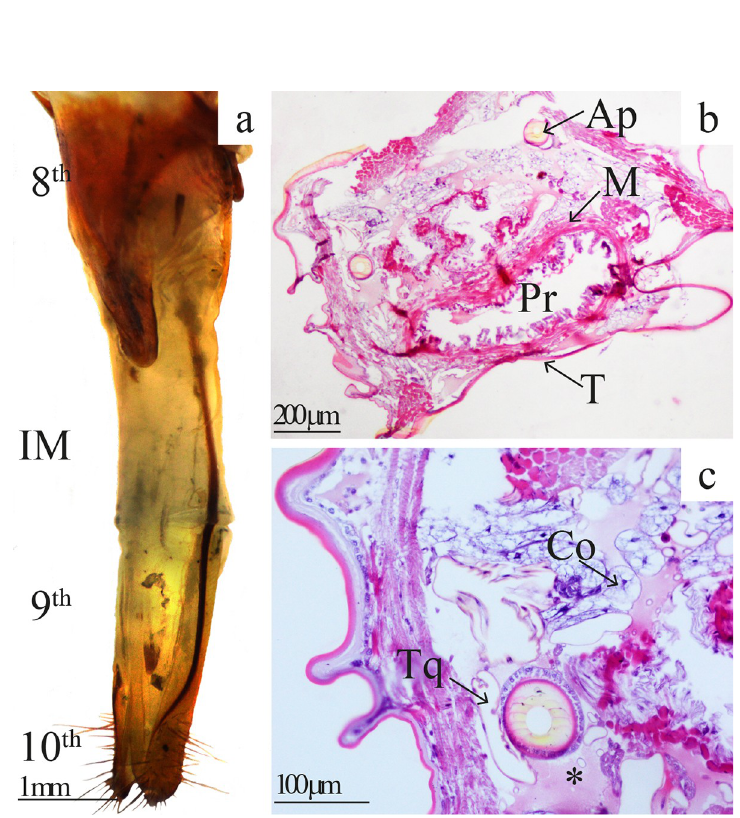
Fig 3. Morphohistological features of the ovipositor of Telchin licus . (a) Dorsolateral view of the ovipositor of T . licus showing the 8 th uromere, intersegmental membrane (IM), and 9 th and 10 th uromeres. (b) Cross-section of the IM showing the tegument (T), muscles (M), proctodeum (Pr) and apodemes (Ap). (c) Enlargement of the cross-sectional area of the IM showing the trachea (Tq), connective tissue (Co) and hyaline eosinophilic fluid ( � ).